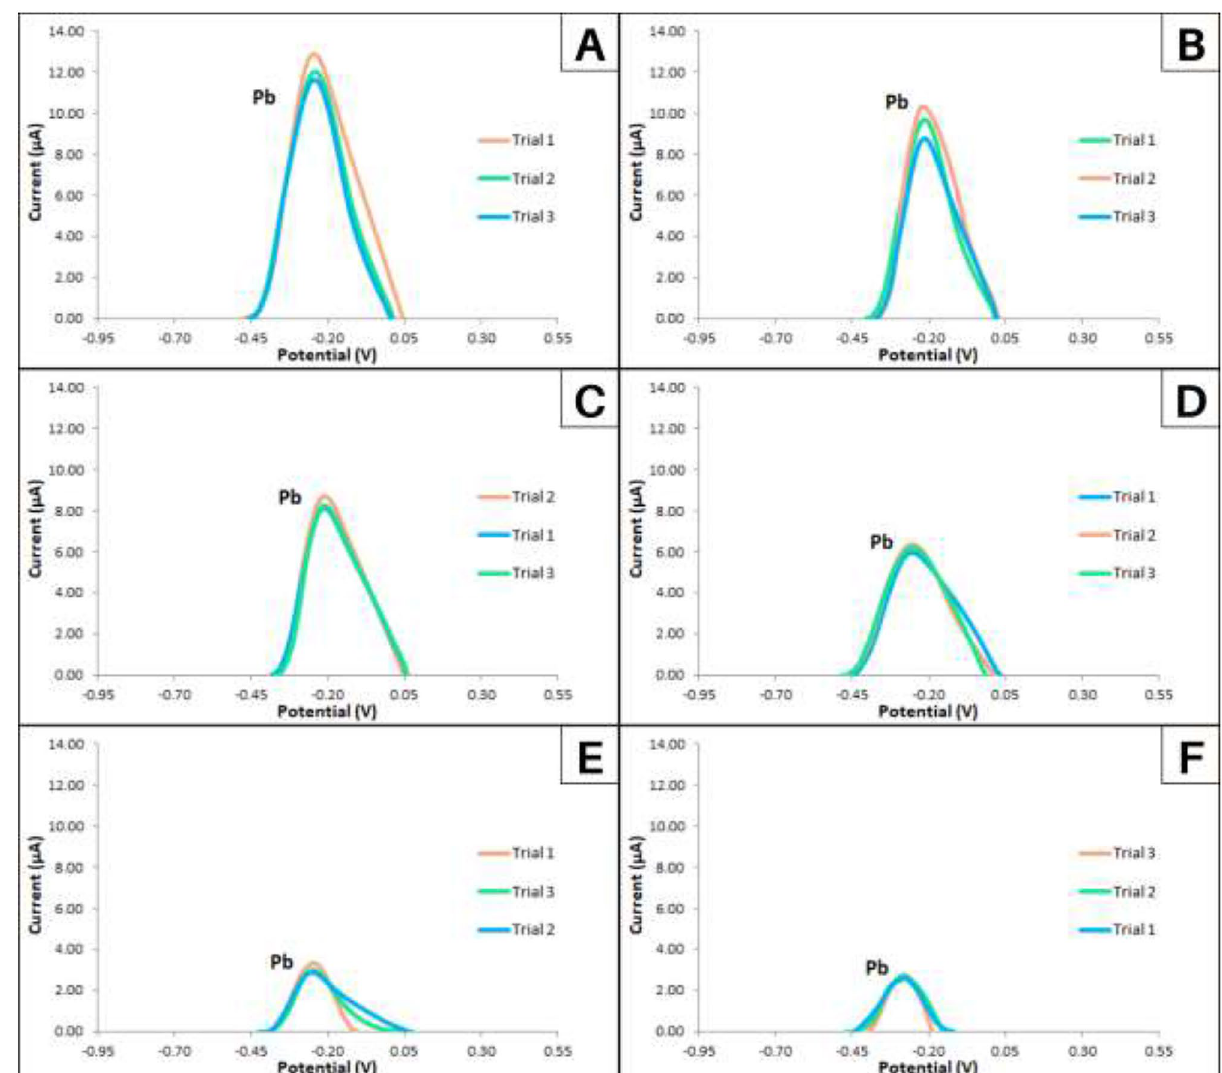
Figure 16. Voltammograms for detection of Pb in ( A ) unremediated water, ( B ) ground sun-dried calamansi powder remediated water, ( C ) dry-ashed calamansi remediated water, ( D ) food grade pectin remediated water, ( E ) fractionated pectin remediated water, and ( F ) AIS extracted pectin remediated